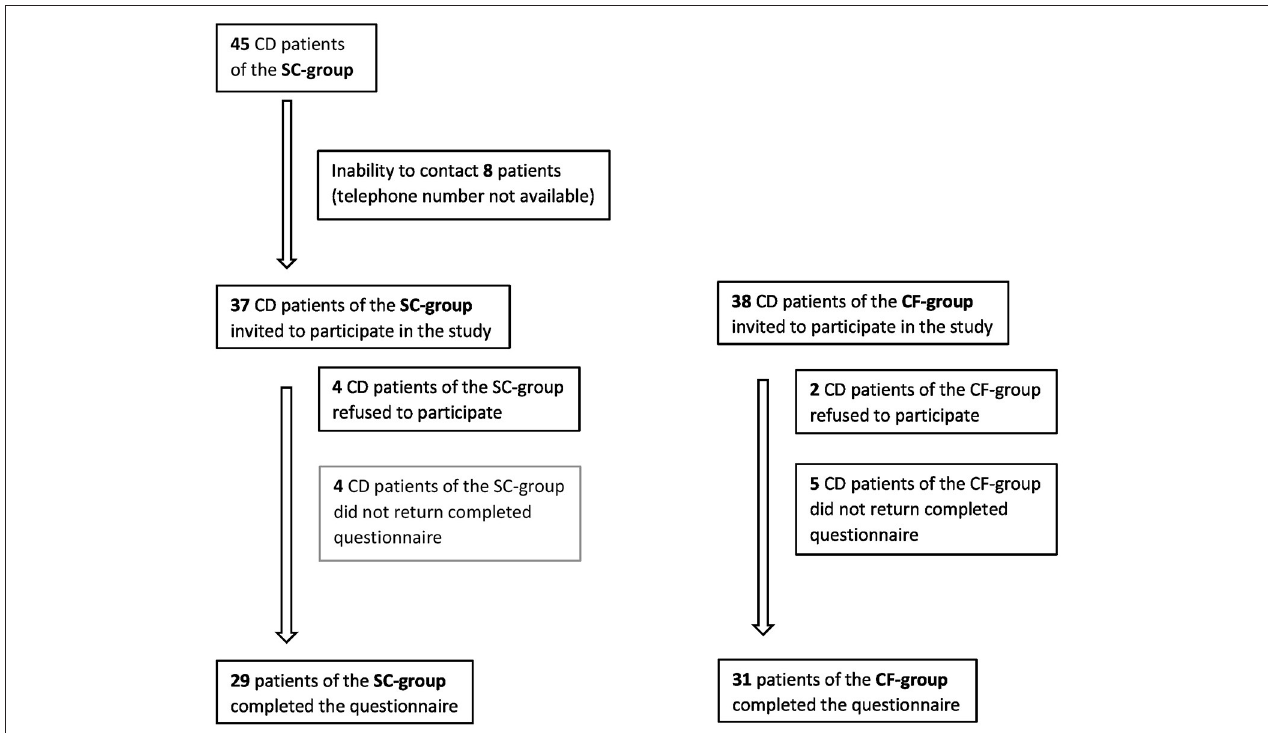
FIGURE 1 | Flow chart of study participants for the screen-detected group and for the case-finding group. SC, screen-detected (group); CF, case-finding (group); CD, celiac